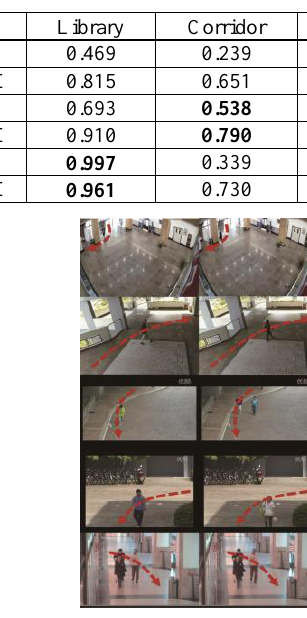
Table 1. Comparison of grouping algorithms.